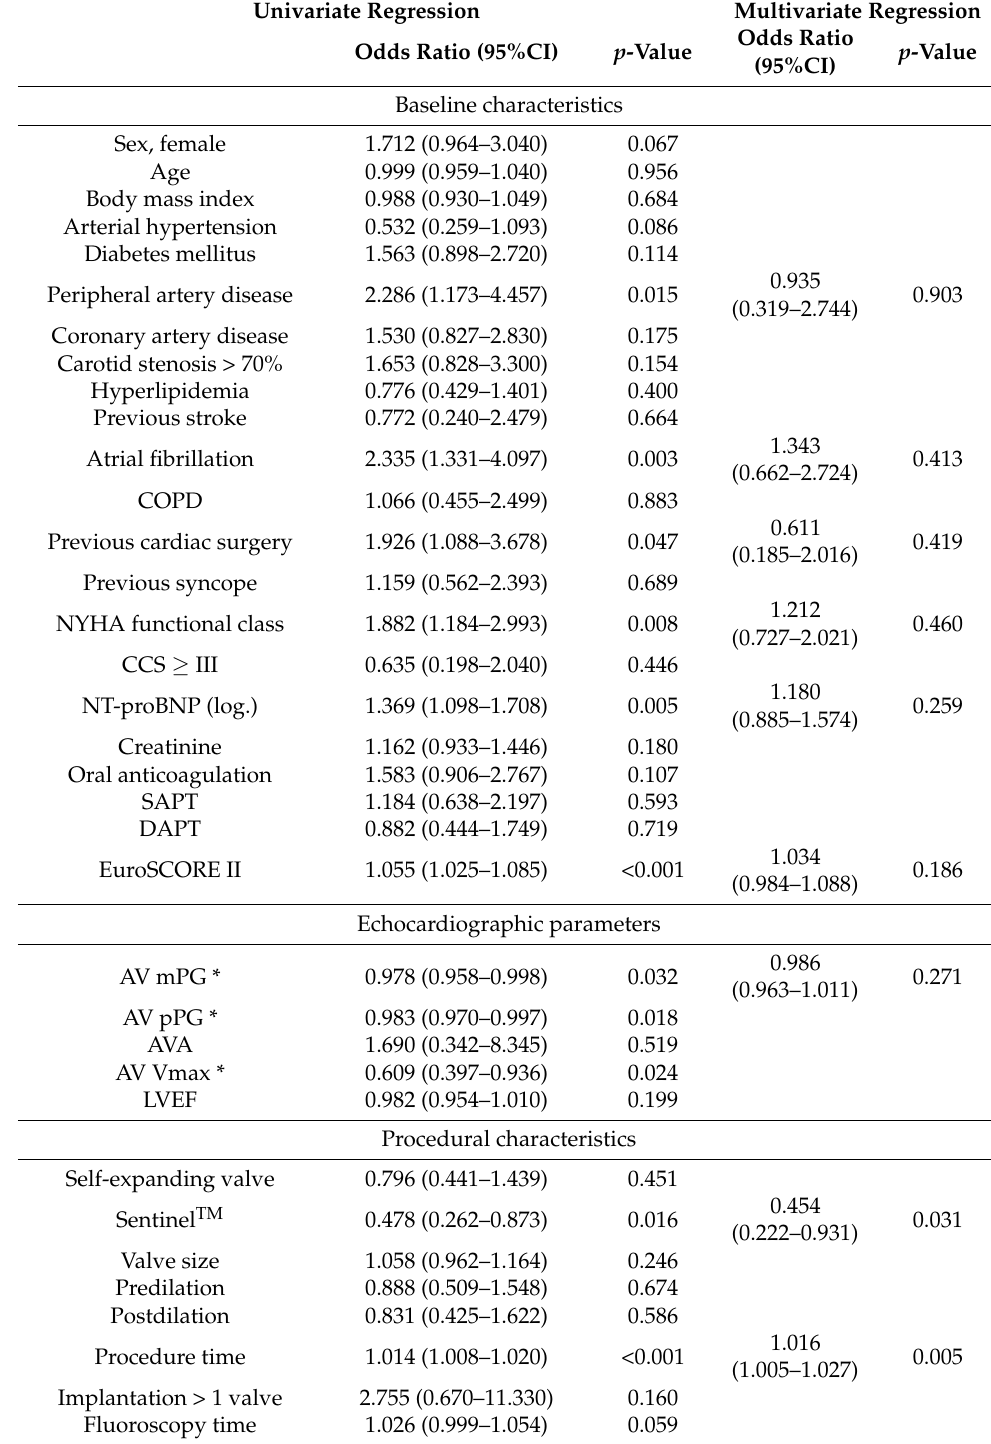
Table 4. Logistic regression analysis—Twelve-months